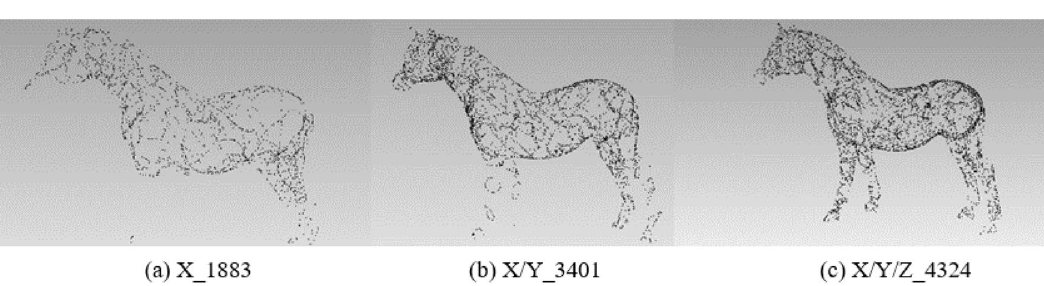
Figure 5. The point cloud with different numbers of feature points extracted with different axes for Horse.